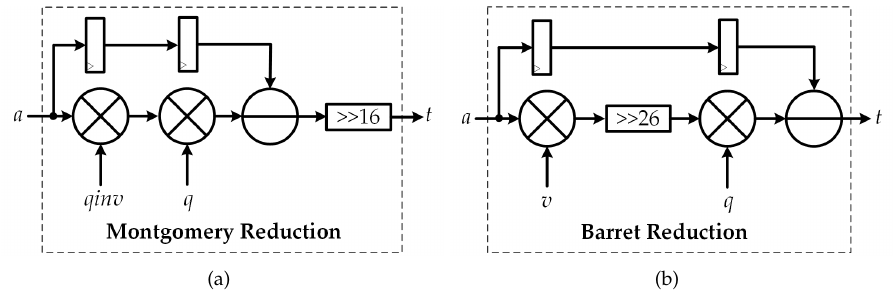
Figure 2. Modulo reduction architectures: ( a ) Montgomery reduction and ( b ) Barret